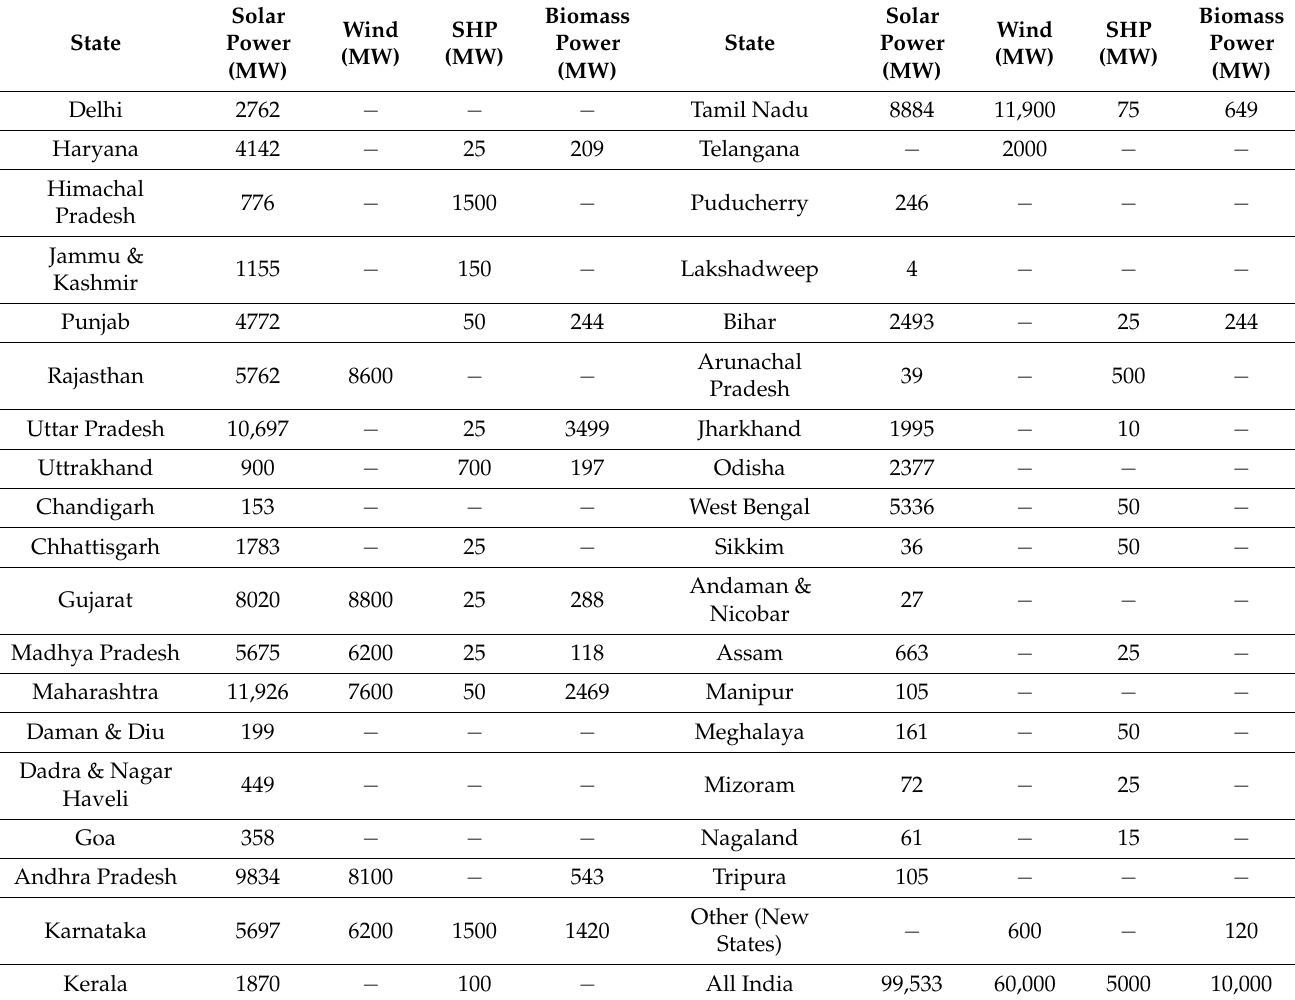
Table 9. Potential distribution of renewable energy goals, by state, to be achieved by 2022, Source: Ministry of New and Renewable Energy (MNRE), Government of India [46].